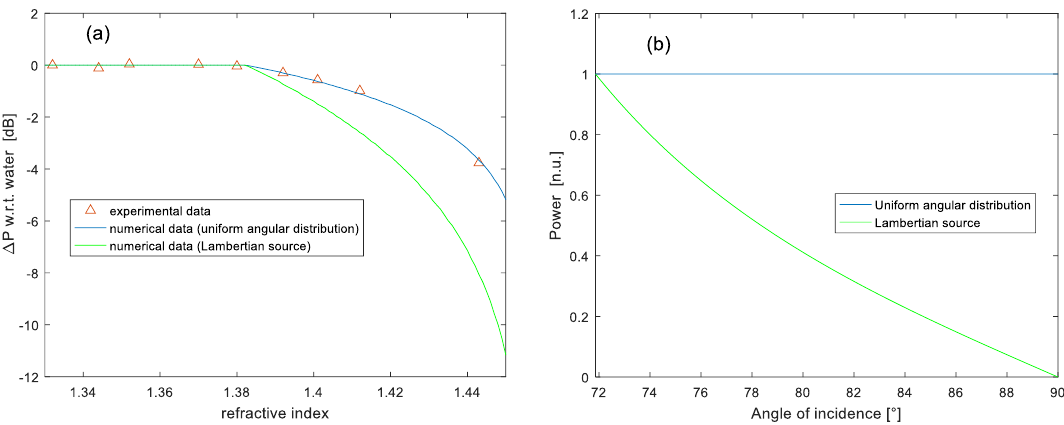
Figure 3. ( a ) Variation of the transmitted power through the LDF as a function of the external medium’s RI. The continuous lines are the simulation results. ( b ) Angular distribution of optical power.